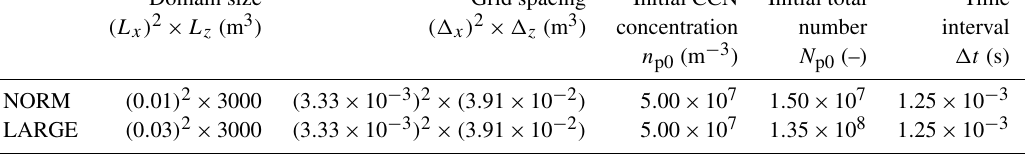
Table 2. Computational conditions for the LCS simulations. The same settings are used for both horizontal axes: x and y directions. Domain size